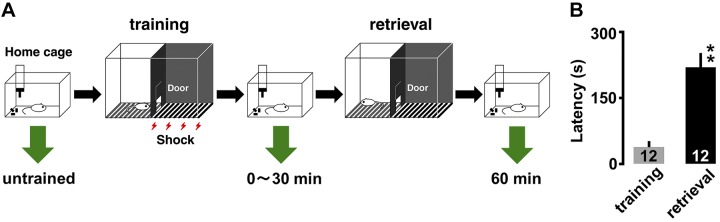
Diagram of experimental design and IA task. A) Rats were housed in a home cage but moved into the light box used for the task on the training day. A brief electrical foot-shock (2 s) was applied in the dark box in the shock cage. Brain slices were prepared at various time points of the training. B) Thirty minutes after the training, the rats consistently showed a longer latency before entering the dark side of the box. **P < 0.01 vs. training. Error bars indicate ± sem. The number of rats is shown at the bottom of each bar.